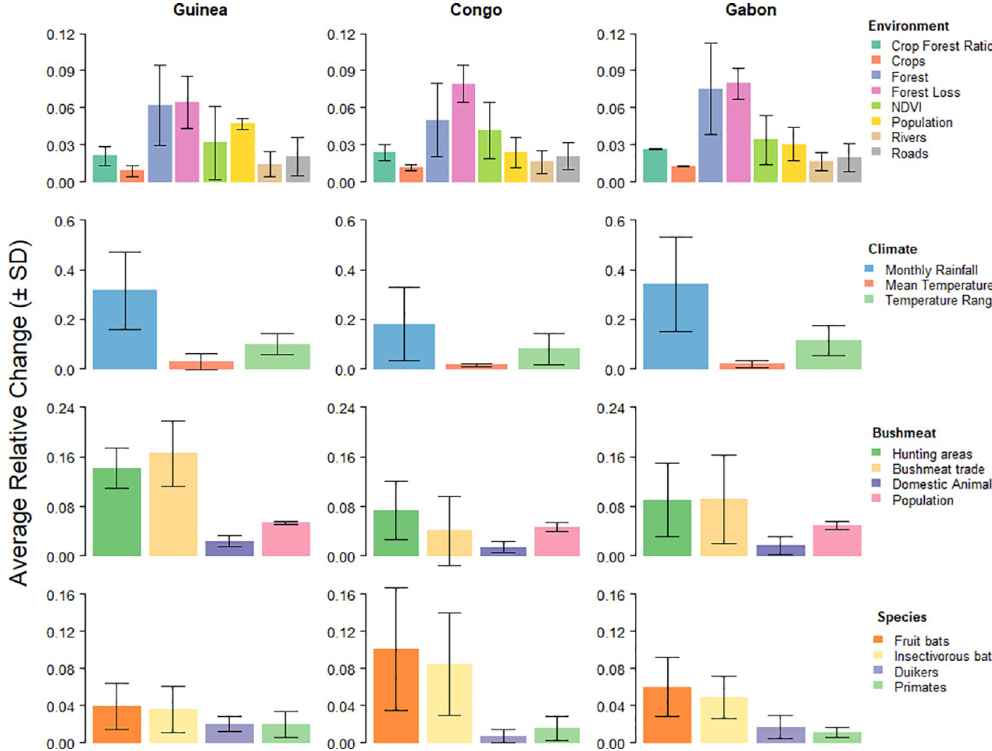
Fig 10. Average relative change in pixel value due to a ± 25% change introduced to the weight of risk factors in each category of risk factors ( i . e . environmental, climatic, associated with bushmeat consumption and associated with potential reservoir/host species) in the three studied areas. Colors correspond to risk factors in the four